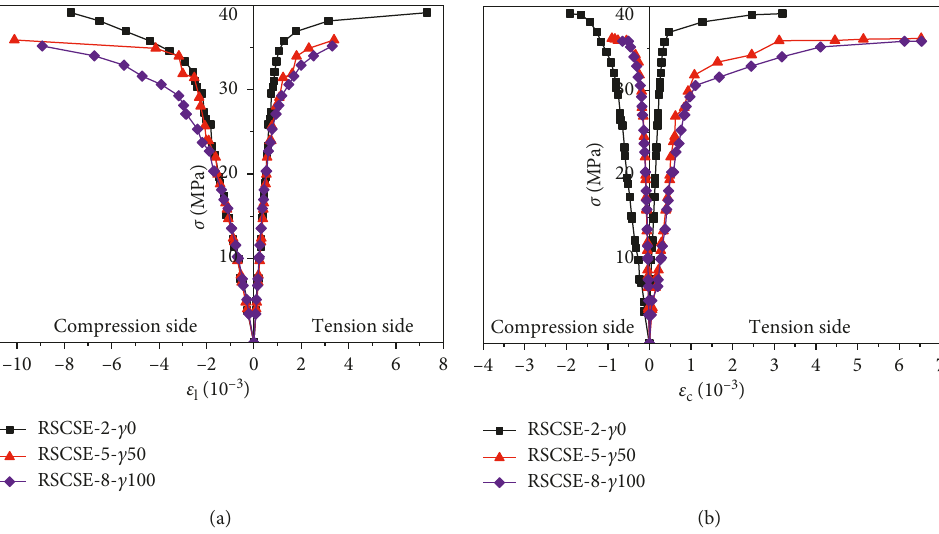
Figure 6: Effect of replacement ratio of RCA on the stress-strain curve ( e